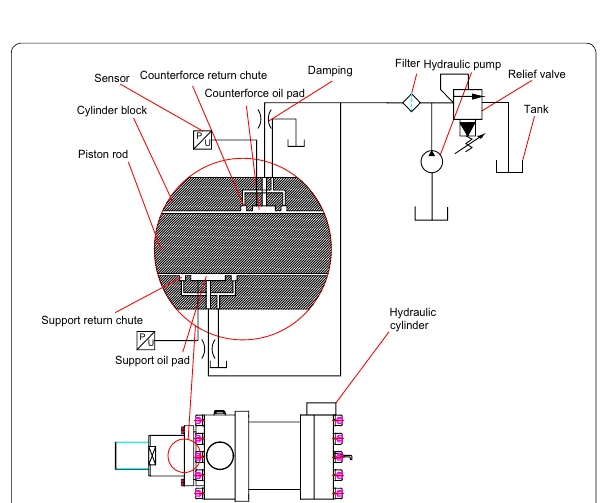
Figure 4 Asymmetric support structure control diagram